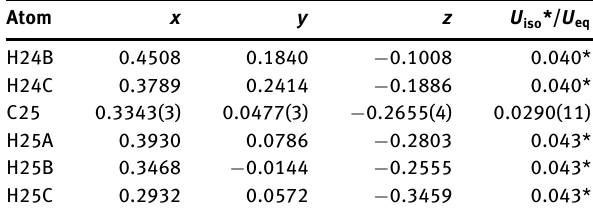
P1#(2.3201(16) Å)andP2—P2#(2.2163(16)